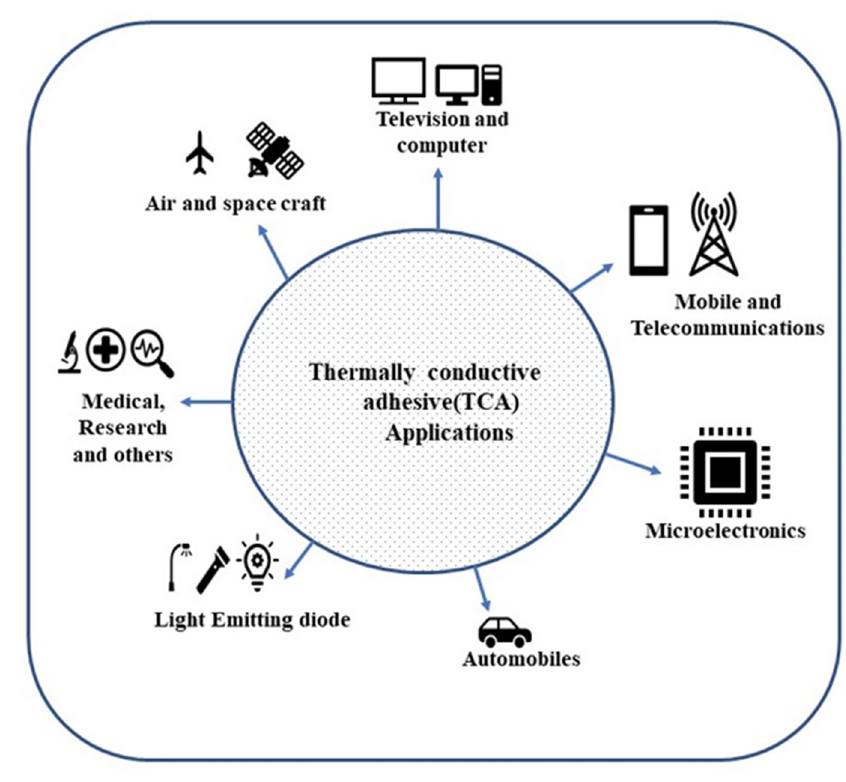
Figure 2. Application of TCAs in different sectors.